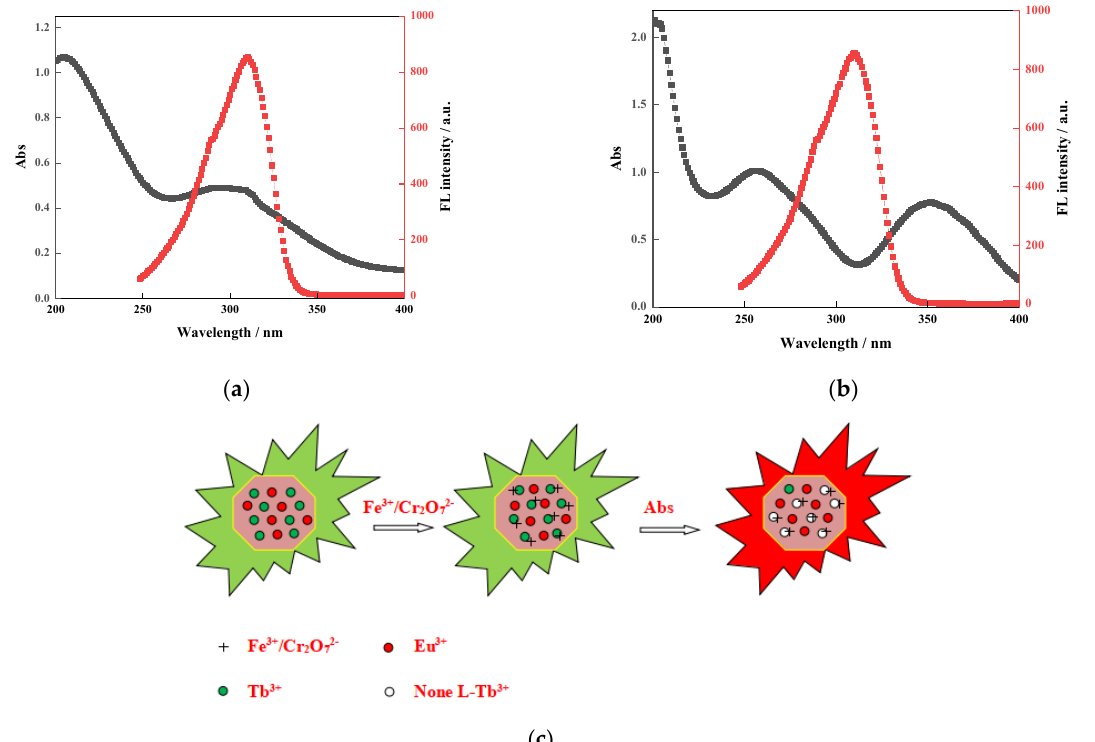
Figure 10. ( a ) Fluorescence excitation spectra of Eu 0.075 Tb 0.925 -MOF and UV-Vis absorption spectra of Fe 3+ . ( b ) Fluorescence excitation spectra of Eu 0.075 Tb 0.925 -MOF and UV-Vis absorption spectra of Cr 2 O 72 − . ( c ) The mechanism of Fe 3+ and Cr 2 O 72 − on Eu 0.075 Tb 0.925 -MOF fluorescence sensing.